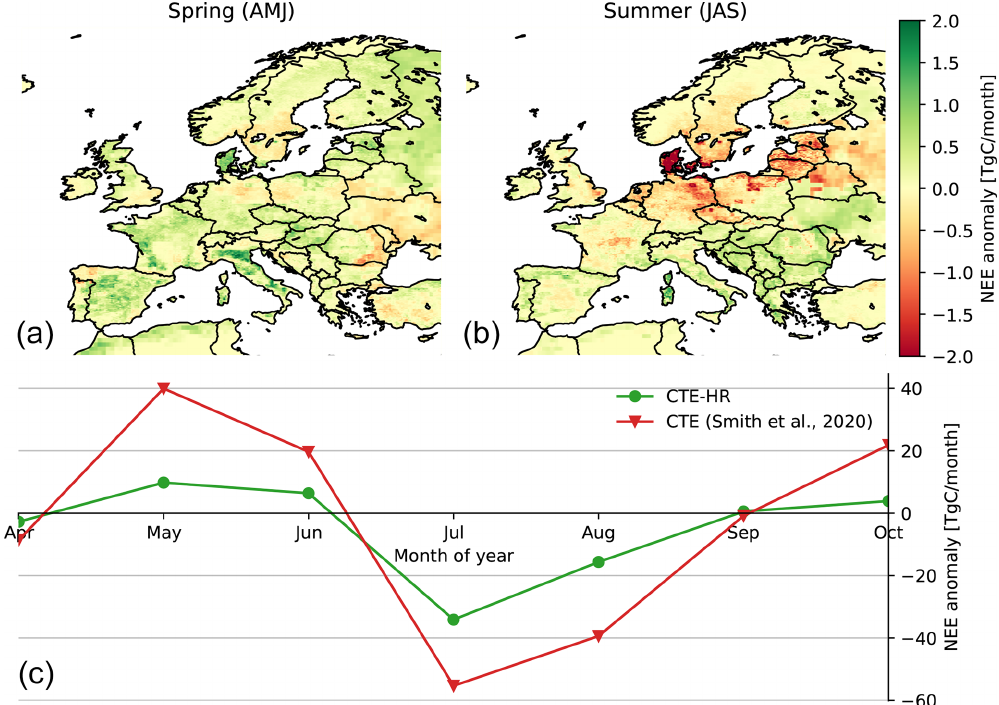
Figure 5. Estimated biosphere flux anomalies in 2018 compared to 2016–2017 for the spring (a) and summer (b) and the progression of the drought under the area influenced by the drought according to Smith et al. (2020) (c) . Anomalies following Smith et al. (2020) are also shown for comparison. Note that Smith et al. (2020) show their anomalies relative to